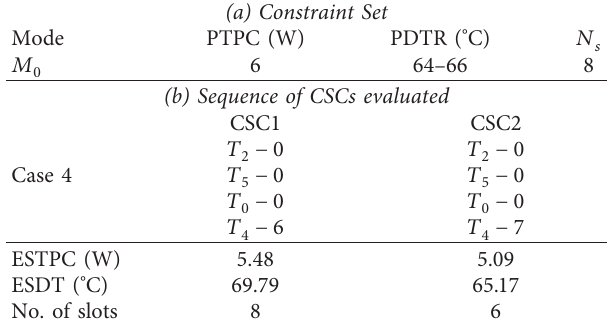
Table 8: Constraint Set and CSCs evaluated for case 4.